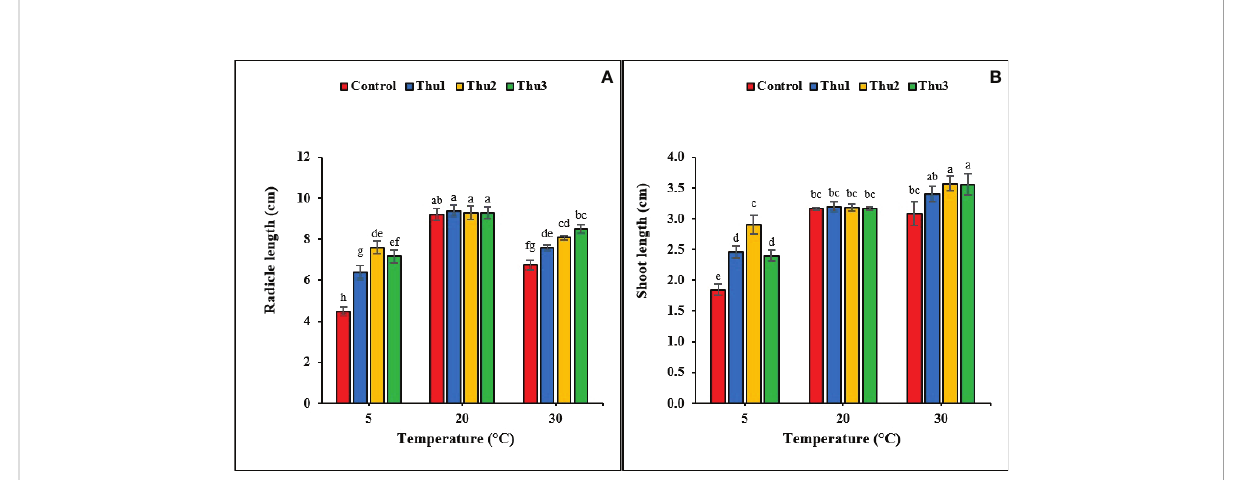
FIGURE 5 Effects of temperature and Th17 concentrations on radical (A) and shoot length (B) . Thu1: 10 -7 M Th17, Thu2: 10 -9 M Th17, Thu3: 10 -11 M Th17. Each bar represents mean ± standard error (n=8). Means with the same letters are not signi fi cantly different ( p < 0.05).